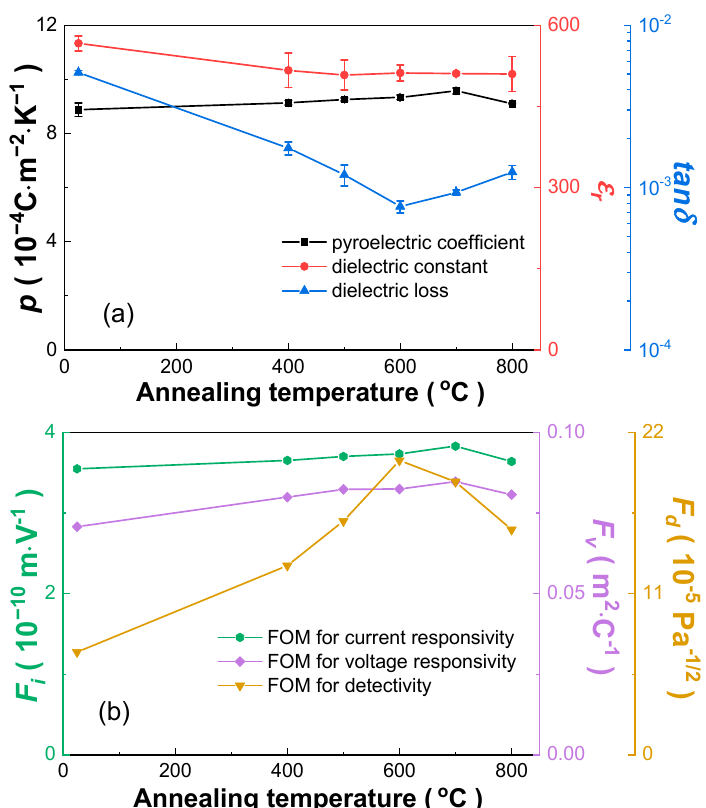
Figure 5. Room temperature-measured dielectric and pyroelectric properties versus annealing temperature of the thick Mn:PIMNT crystals. ( a ) p , ε r and tan δ ; ( b ) F i , F v and F d .